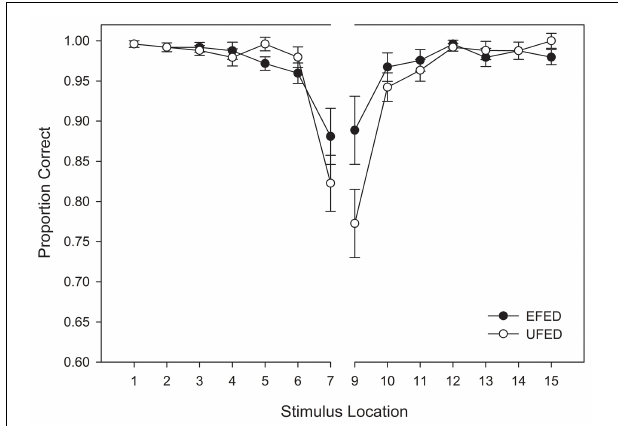
FIGURE 8 | Mean categorization response frequencies for equal frequency (EFED) and unequal frequency conditions (UFED). Stimulus values correspond to stimuli selected from the entire stimulus range (i.e., stimuli 1–15). Vertical dashed lines represent the estimated category